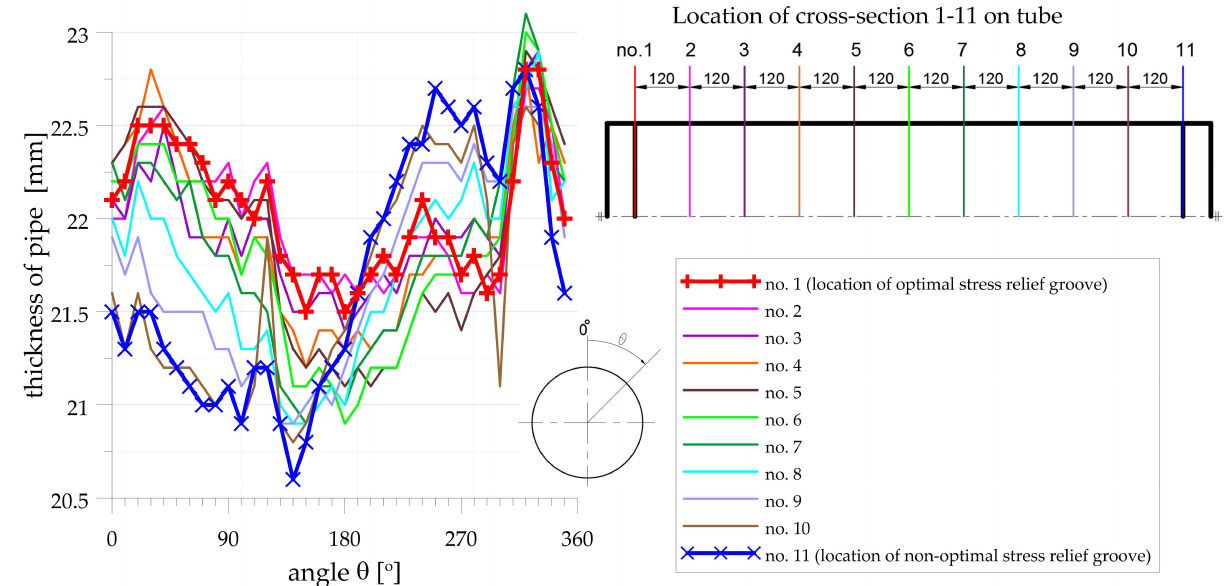
Figure A4. Measured thickness of cylindrical pipe of vessel in different